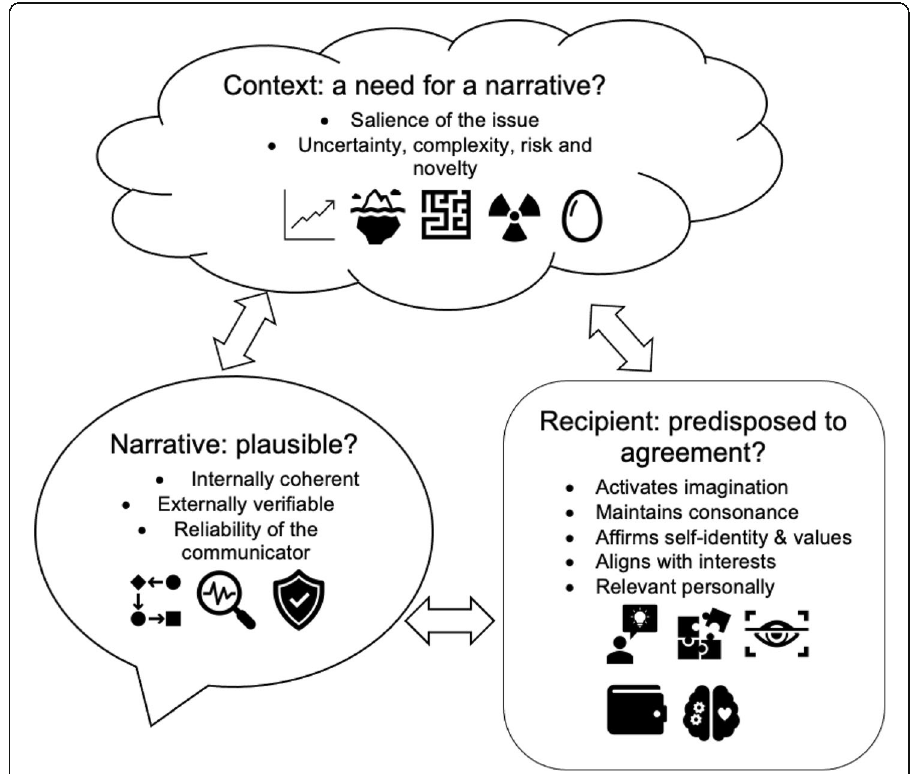
Fig. 1 Theoretical framework for variation in narrative